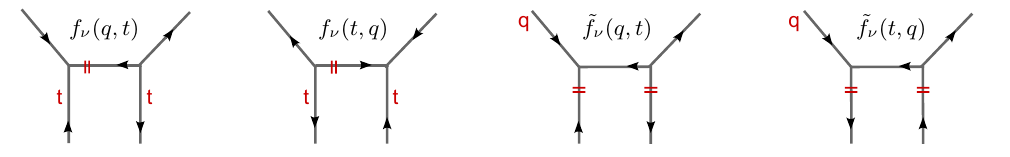
Figure 3 . The integer n e associated to the edge e in the graph is de(cid:12)ned as n e = det ( ~v in ~v out ). Thus for the graphs in the middle and on the right, this yields n e = 1 and n e = 0, respectively.